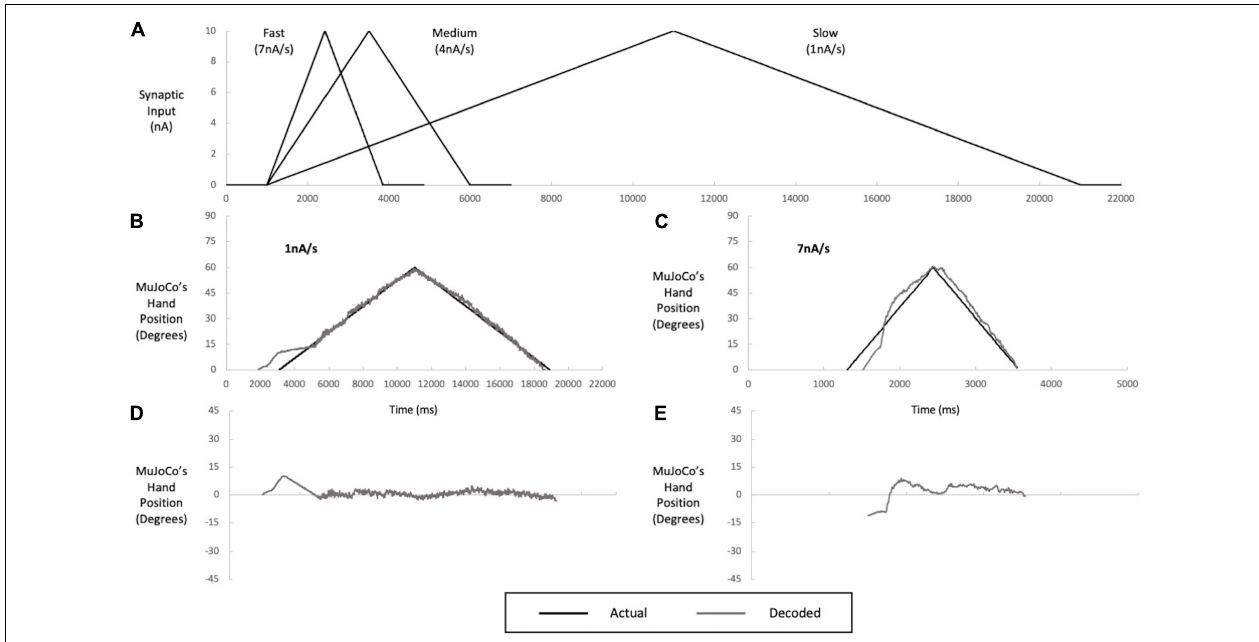
FIGURE 4 | Multi speed testing of a single-speed decoder (calibrated to an intermediate speed input of 4 nA/s). (A) Inputs of slow (1 nA/s), medium (4 nA/s), and fast (7 nA/s) speeds used in decoder calibration and testing. The decoder was calibrated to the medium speed but tested on the slow (B) and fast (C) speeds. Performance of the medium-speed calibrated decoder when tested with slow (B) and fast (C) inputs, illustrated by a comparison of MuJoCo’s hand position when driven by the actual (black) vs. decoded (gray) inputs. The instantaneous error in MuJoCo’s hand position when the medium-speed calibrated decoder was tested with slow (D) and fast (E)